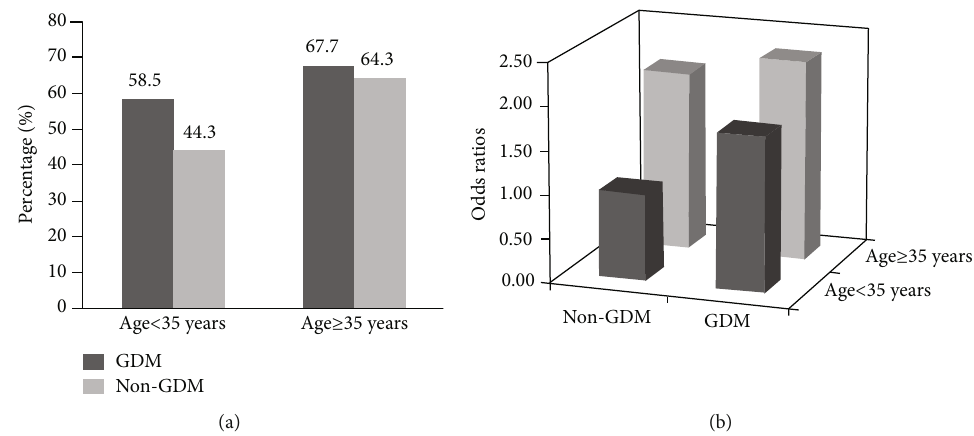
Figure 2: Associations of gestational diabetes mellitus and maternal age with the risk of cesarean delivery. (a) Percentage of gestational diabetes mellitus by maternal age groups. Values are n (%). (b) Adjusted odds ratios for cesarean delivery according to di ff erent gestational diabetes mellitus and maternal age groups. Values are odds ratios. Adjusted for maternal age, education, employment, annual household income, study centers, drinking during pregnancy, passive smoking during pregnancy, prepregnancy body mass index categories, parity, use of assisted reproductive technology, folic acid supplementation, gestational age at delivery, and gestational weight gain categories. Abbreviations: GDM: gestational diabetes